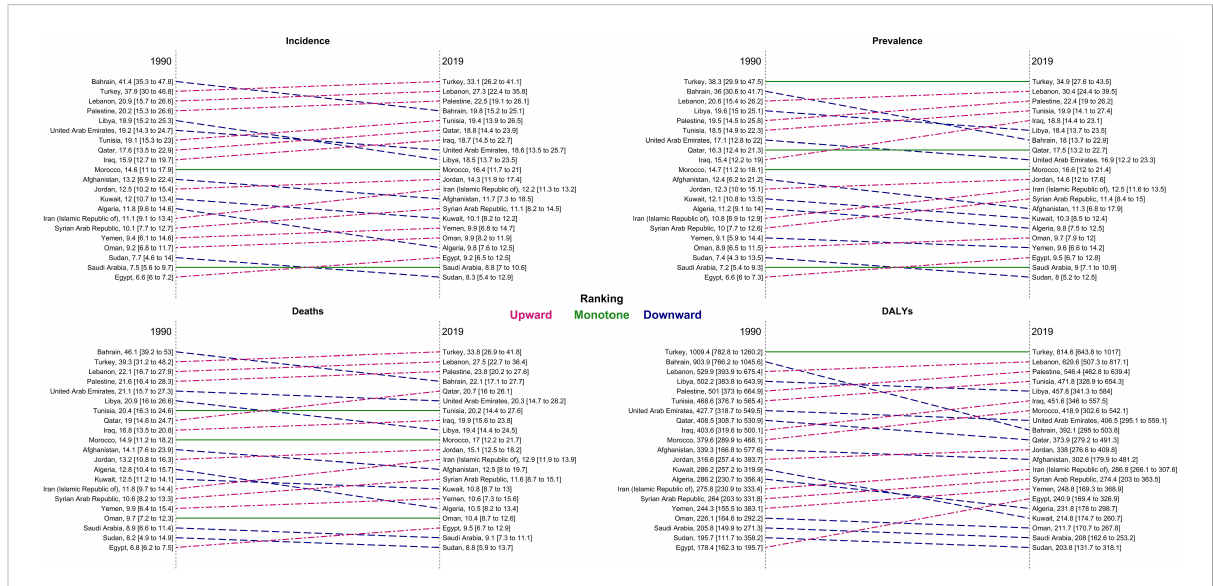
FIGURE 3 Ranking of age-standardized rate of incidence, prevalence, deaths, and DALYs in countries of the region, 1990 compared with 2019 DALYs = disability-adjusted life years .